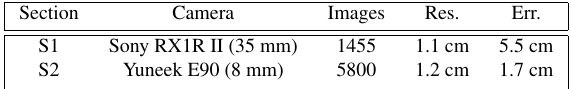
Table 1. UAV survey characteristics, model resolution (Res.) and total error calculated during the modelling